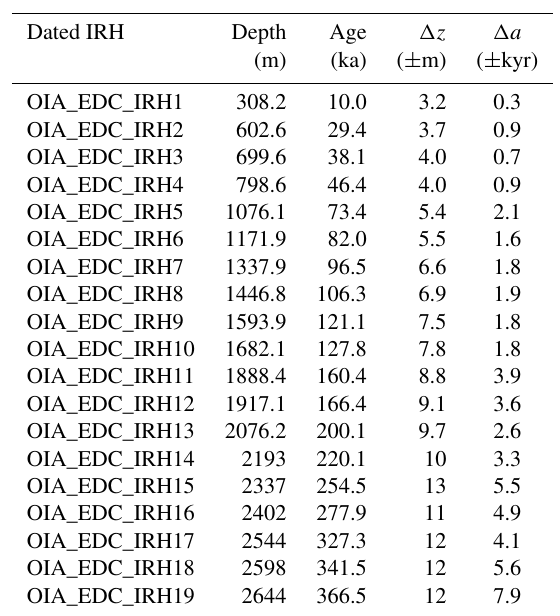
Table 3. Depths, ages and uncertainties of the 19 dated IRHs, mea- sured and calculated at the EDC site, using the AICC2012 chronol- ogy (Bazin et al., 2013; Veres et al., 2013). (cid:49)z and (cid:49)a stand for depth and age uncertainty,